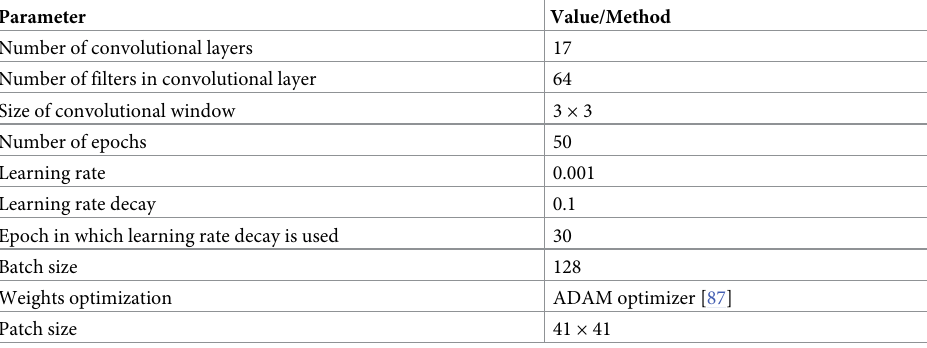
Table 2. Summary of CNND detector parameters